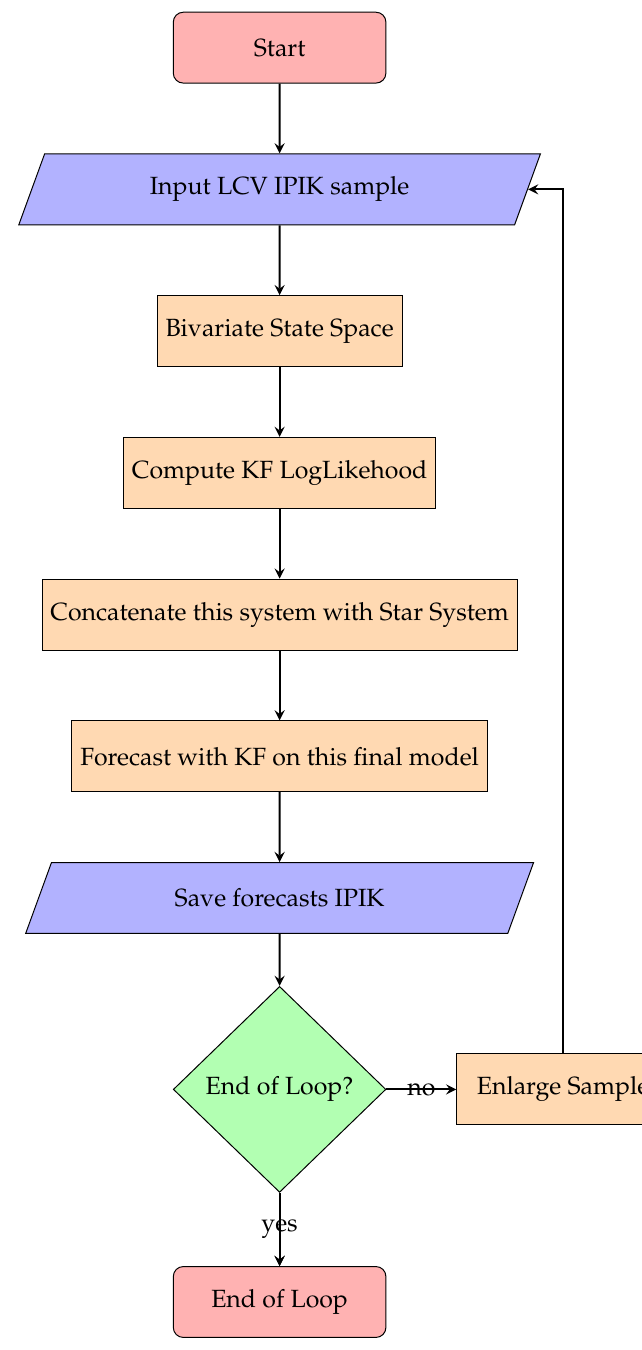
Figure 5. Concatenate Seemingly Unrelated Time Series Equations with star